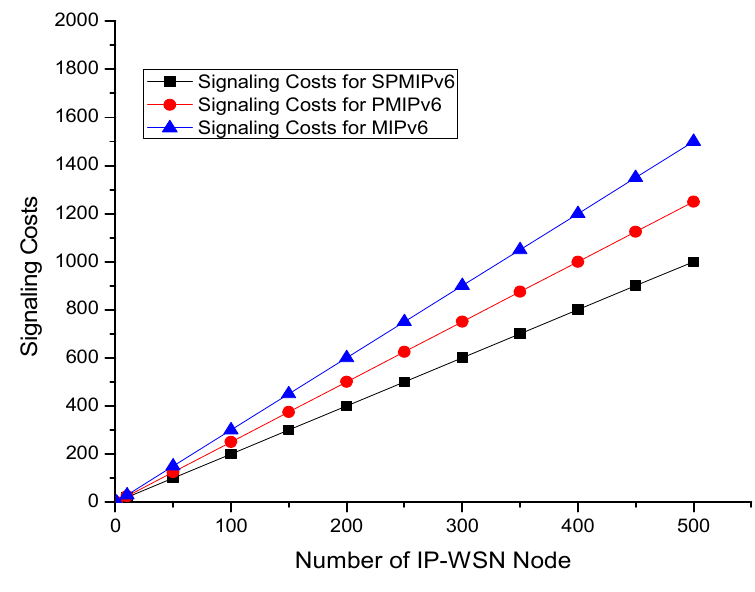
Figure 15. Number of IP-WSN nodes vs. Signaling